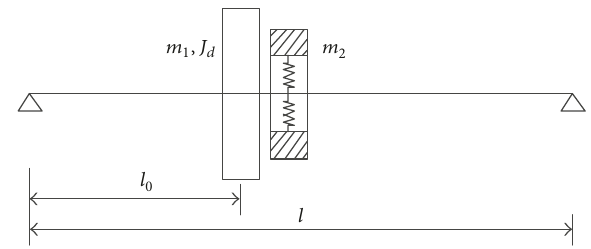
Figure 6: Rotor system used for numerical